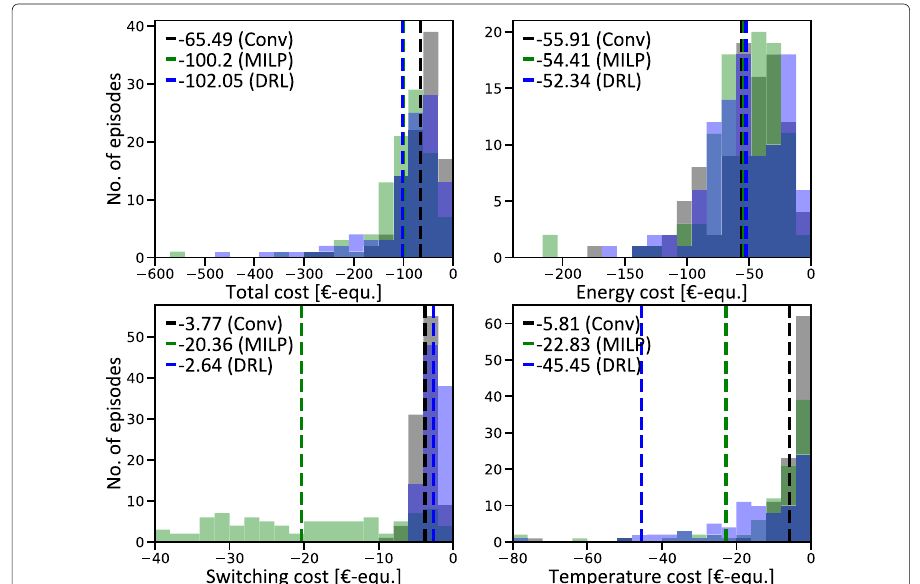
Fig. 8 Distribution and mean value of overall and specific cost per episode for system B . Cost in this case are interpreted as negative rewards, thus increasing performance is indicated by higher values. Black: Conventional controller, Blue: DRL controller, Green: MILP controller